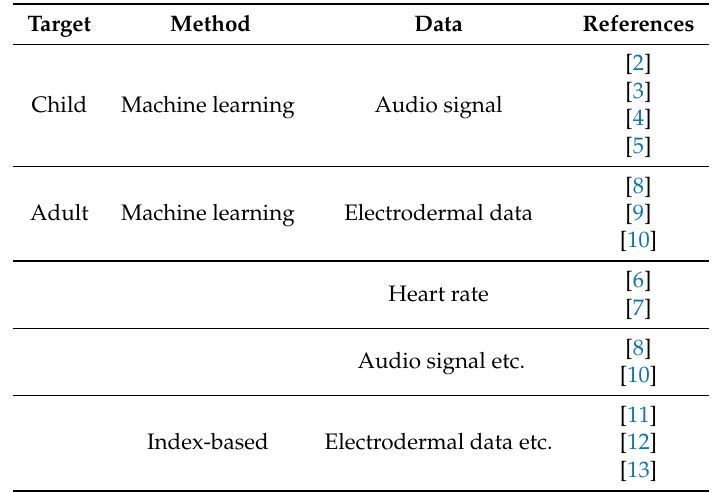
Table 1. Summary of previous research on stress detection in terms of their target, utilized method, and